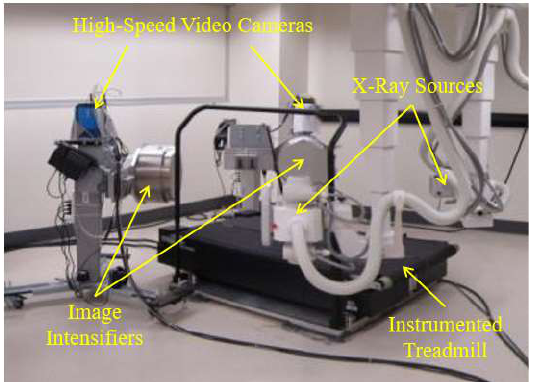
Figure 1. HSBV motion capture system.